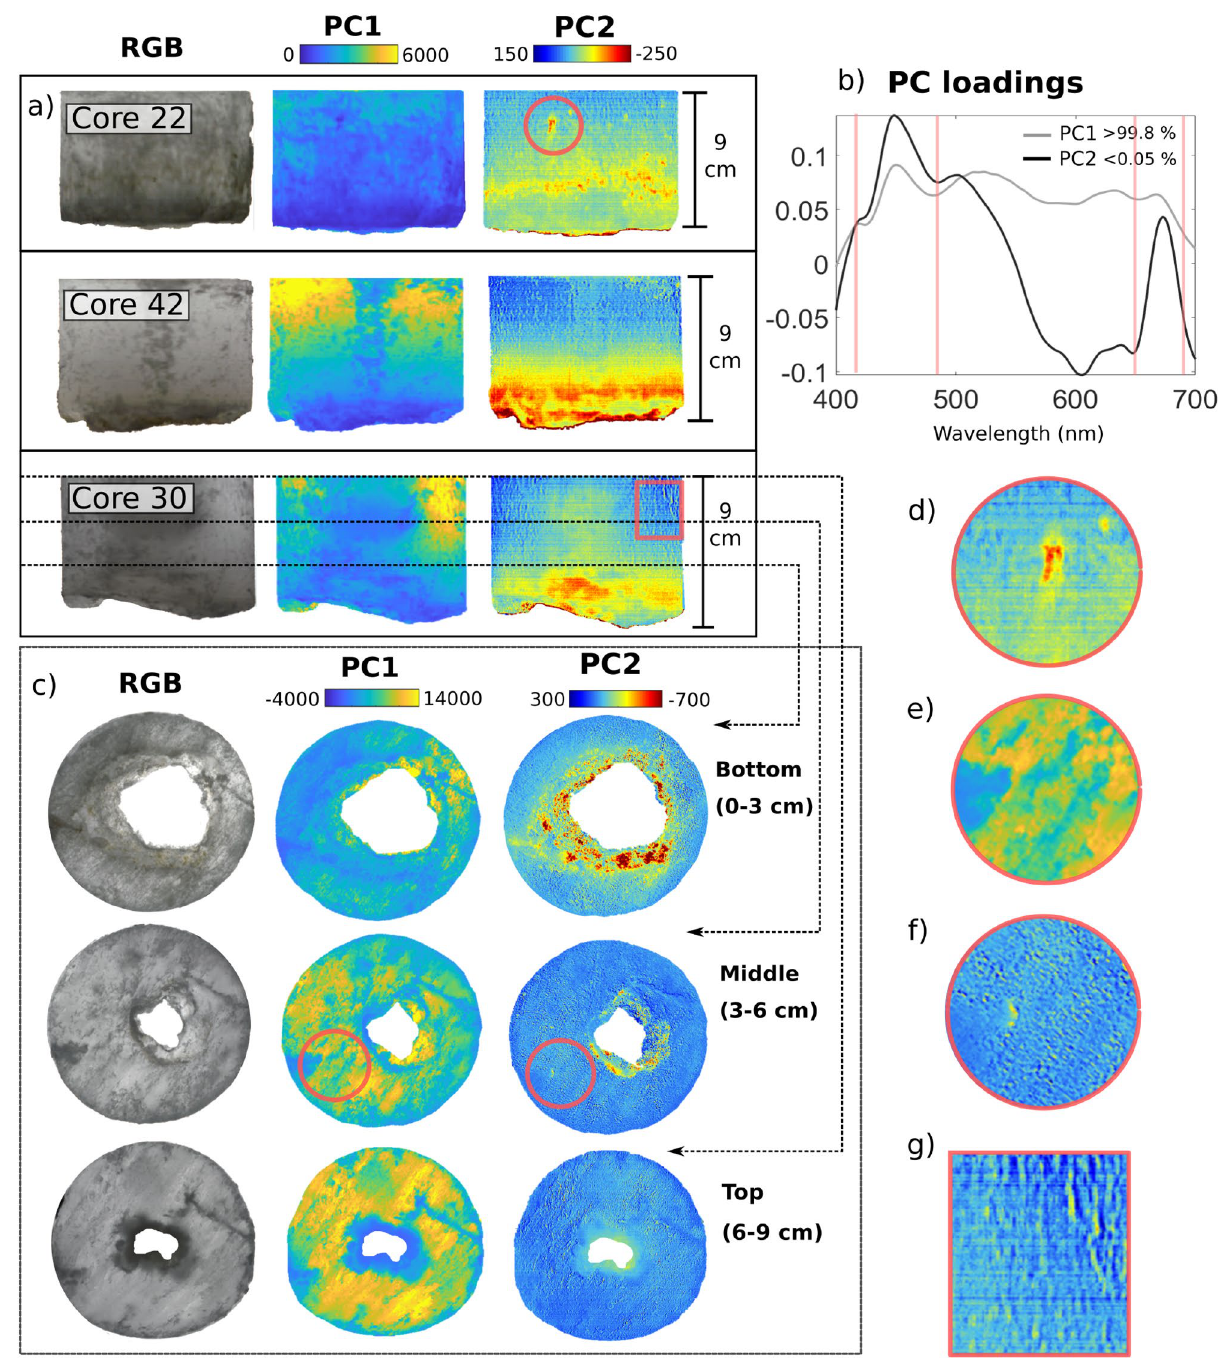
Figure 4. Results of unsupervised exploration using Principal Component Analysis on selected ice core sections. PC analysis was performed independently on pooled vertical and horizontal sections separately. ( a ) three selected vertical scans of cores 22 and 42 are shown alongside core 30, which contained a large cavity that was further explored with horizontal scans of bottom, middle and top sections. ( b ) PCs loadings intensity (unitless). PC1 accounts for > 99.8% of variation and loadings exhibit the spectral signature of the light source thus provides a proxy of transmitted light intensity. PC2 accounts for < 0.05% of variation and loadings are strongly associated with the Chl a absorption spectrum. Scores of PC2 map are a proxy of Chl a within the cores vertical and horizontal dimensions. ( c ) Horizontal scans and analysis of core 30 characterized by a large cavity feature (see Fig. 3f). The horizontal sections were sliced following the vertical scan. Panels ( d ), ( e ) and ( g ) are zoomed views of selected features of interest such as apparent brine pockets and channels inhabited by algae. ( e ) zoomed view of apparent ice textural properties. RGB composites of the ice core sections were produced using bands at wavelengths 647 nm, 554 nm and 462 nm